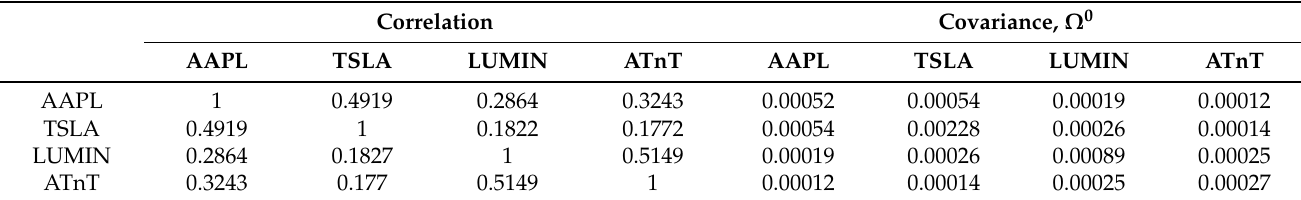
Table 2. Correlation and covariance of stock